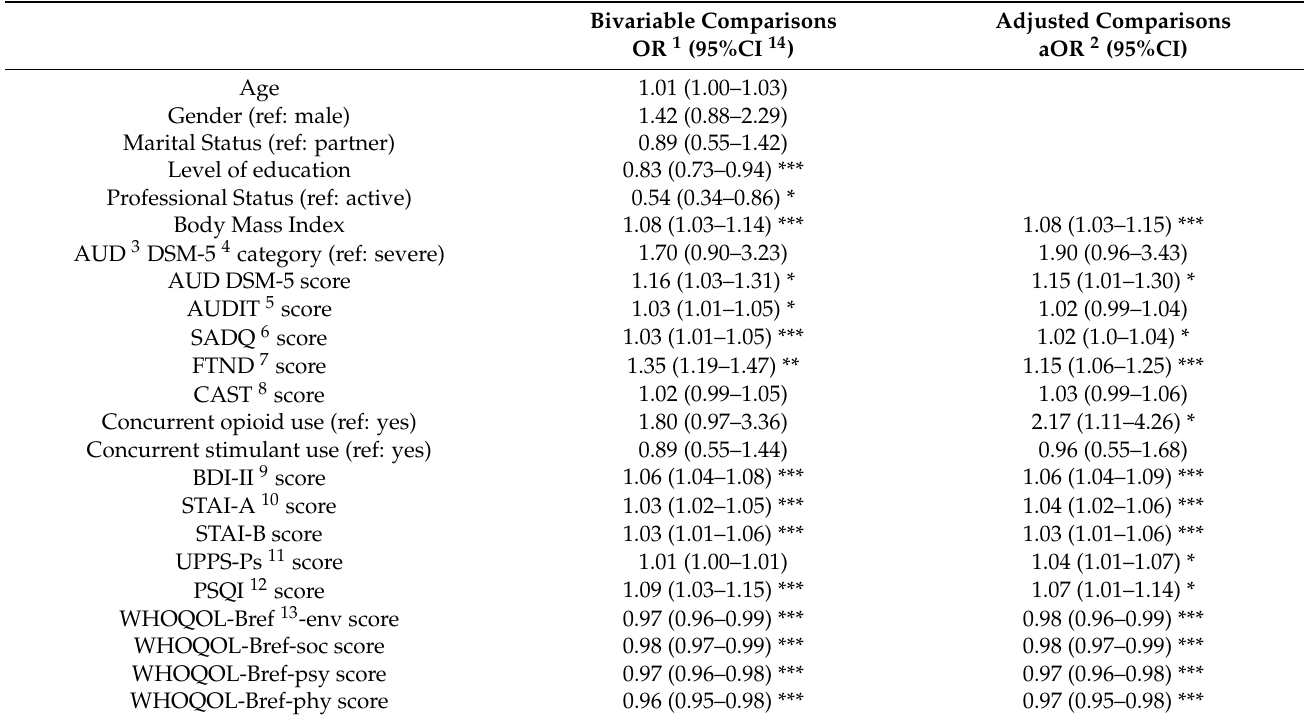
Table 2. Multivariable logistic regression models, each adjusted for age, gender, marital status, level of education, and professional status. Bivariable